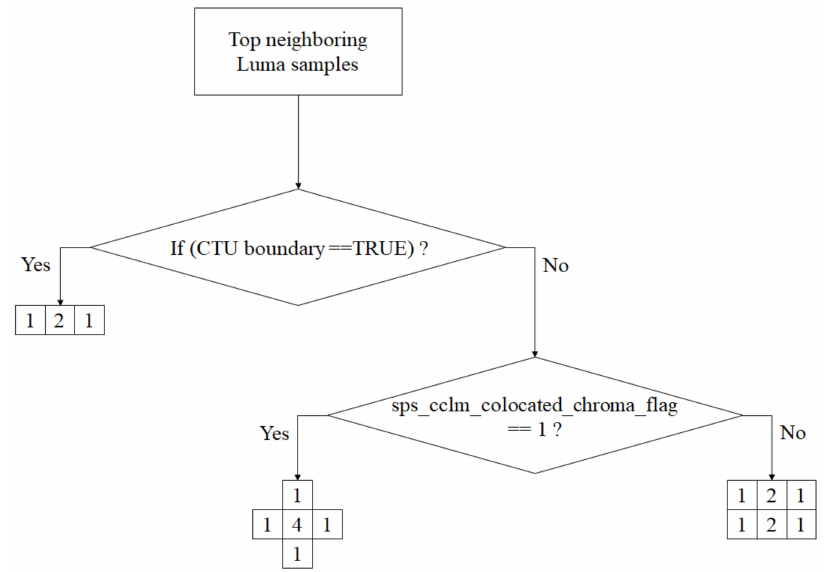
Figure 11. Flow chart of downsampling filter shape selection for top neighboring luma samples in the proposed CCLM.